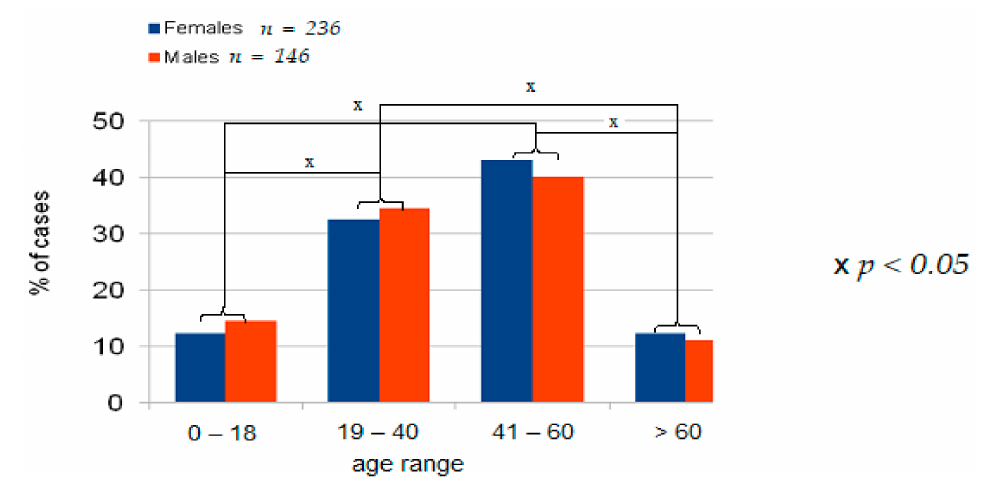
Figure 2. Distribution of patients by age range and sex in the analyzed group.